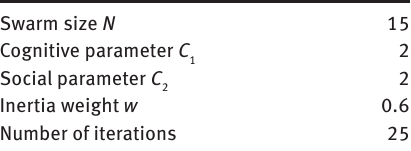
Table 2: PSO Parameters.